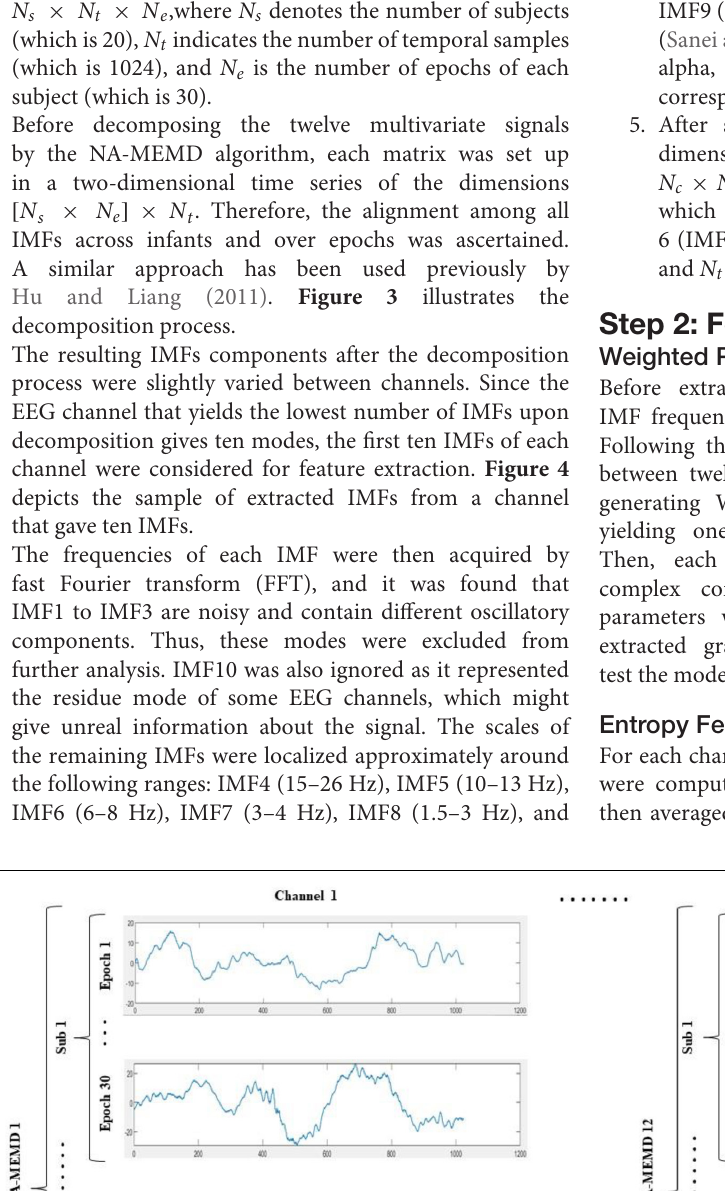
Frontiers in Human Neuroscience |